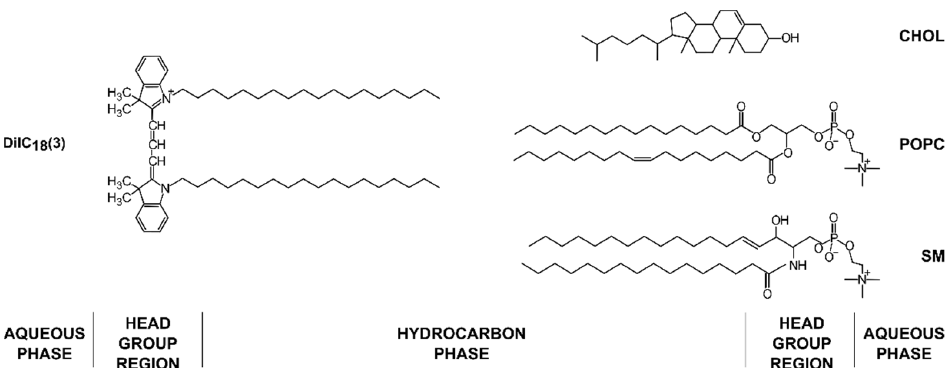
Figure 1. Chemical structures of lipids and the fluorescent dye used in the experiments with their approximate locations in the membrane bilayer.